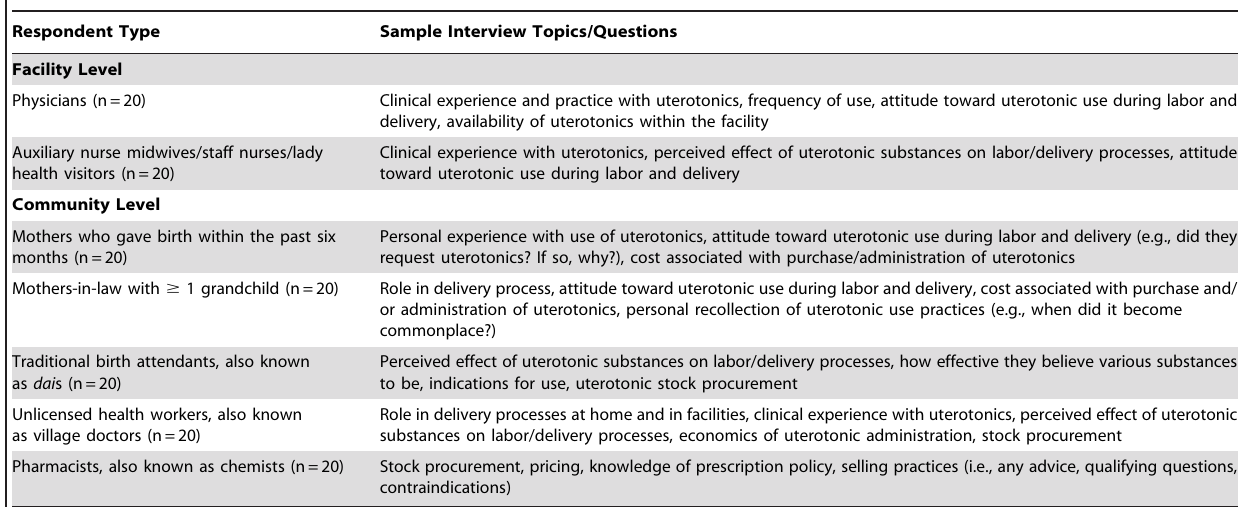
Table 2. Interview Topics by Respondent